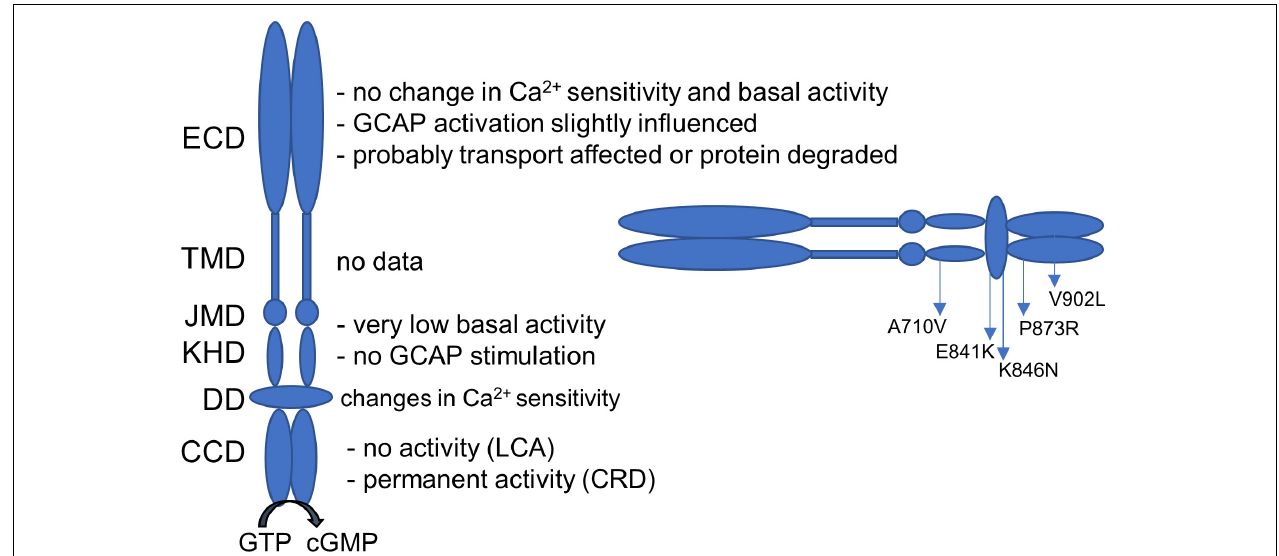
FIGURE 6 | Guanylate cyclase domains and the effect on GUCY2D mutations on the enzyme function. Dependent on the localization, mutations can have several consequences on GC-E function. Localization of the investigated mutations is given. ECD, extracellular domain; TMD, transmembrane domain; JMD, juxtamembrane domain; KHD, kinase homology domain; DD, dimerization domain; CCD, cyclase catalytic